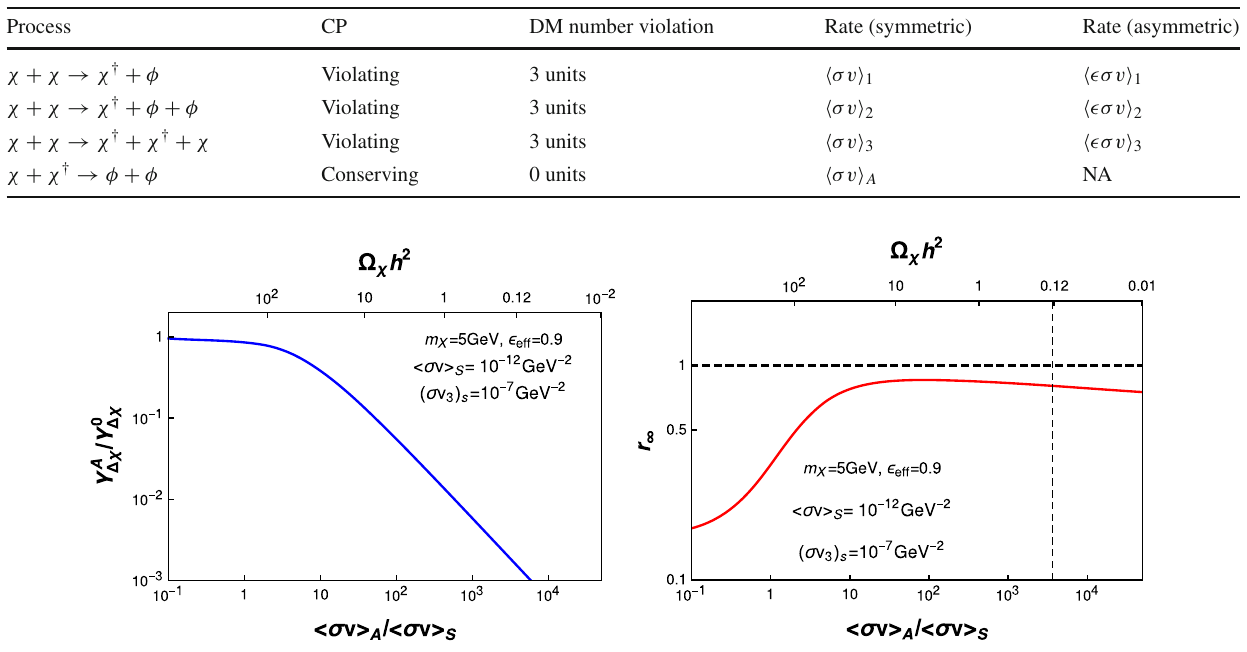
where, we have defined (cid:9) σv (cid:10) S = (cid:9) σv (cid:10) 1 + (cid:9) σv (cid:10) 2 . Here, the thermallyaveragedrate (cid:9) σv (cid:10) 3 hasasignificant x −